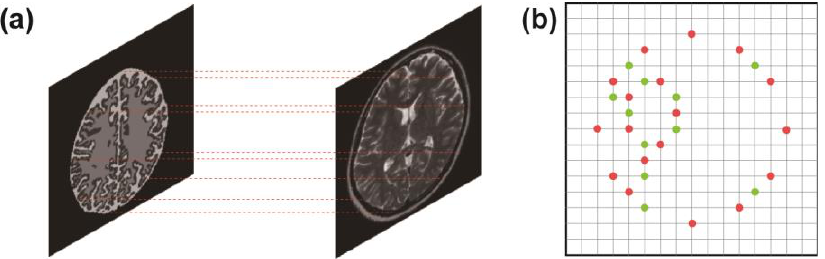
Figure 1. Overall architecture of our reverse-net.